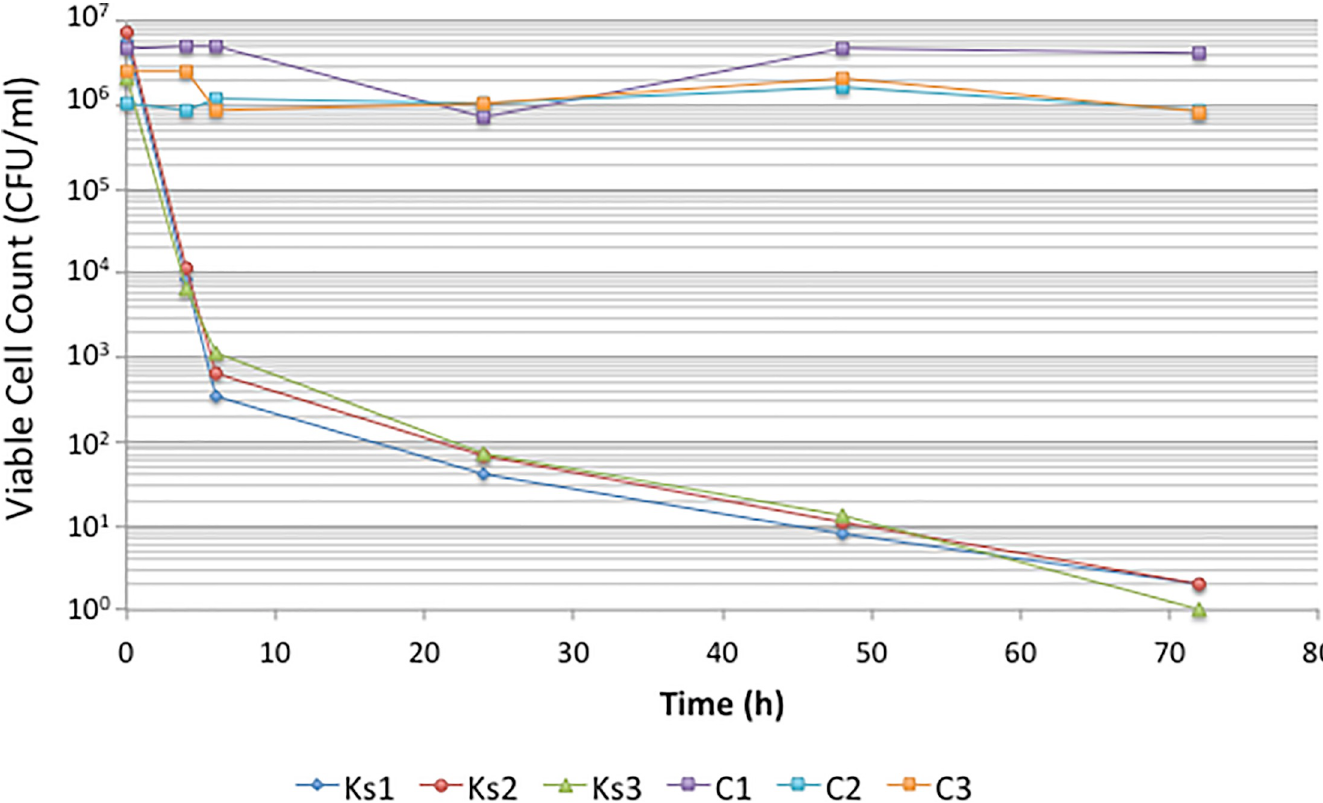
Fig 2. Inhibition of C . graminicola by kochia exudate (100 mg ml -1 ). Three independently extracted exudates were tested (Ks1, Ks2, Ks3). Control samples (C1, C2, C3) were untreated cells.